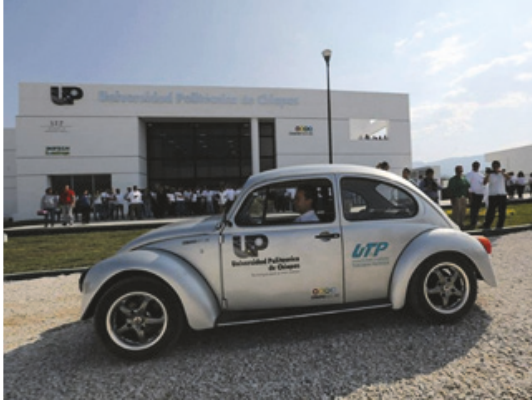
Figure 1: Electric vehicle